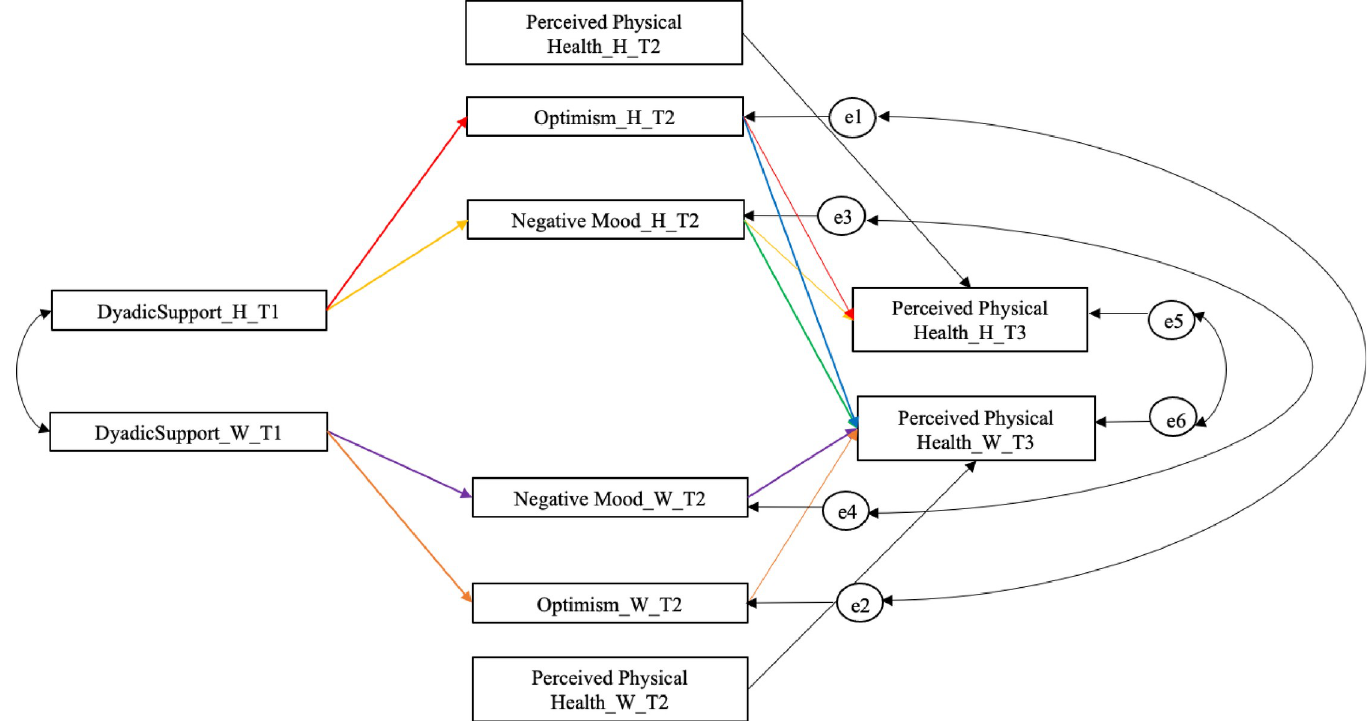
Fig 3. APIMeM with only significant contrasts between indirect actor effects and between indirect actor-partner effects estimated. Note : H = husband; W = wife. Dyadic support stands for all the predictor variables (emotional and practical support). Indirect Effect 1 (yellow lines) = Support Husbands ! Depressive mood Husbands ! Health Husbands; Indirect Effect 2 (red lines) = Support Husbands ! Optimism Husbands ! Health Husbands; Indirect Effect 3 (purple lines) = Support Wives ! Depressive mood Wives ! Health Wives; Indirect Effect 4 (orange lines) = Support Wives ! Optimism Wives ! Health Wives; Indirect Effect 5 (green lines) = Support Husbands ! Depressive mood Husbands ! Health Wives; Indirect Effect 6 (blue lines) = Support Husbands ! Optimism Husbands ! Health Wives. Data Source: Swiss Household Panel (SHP).